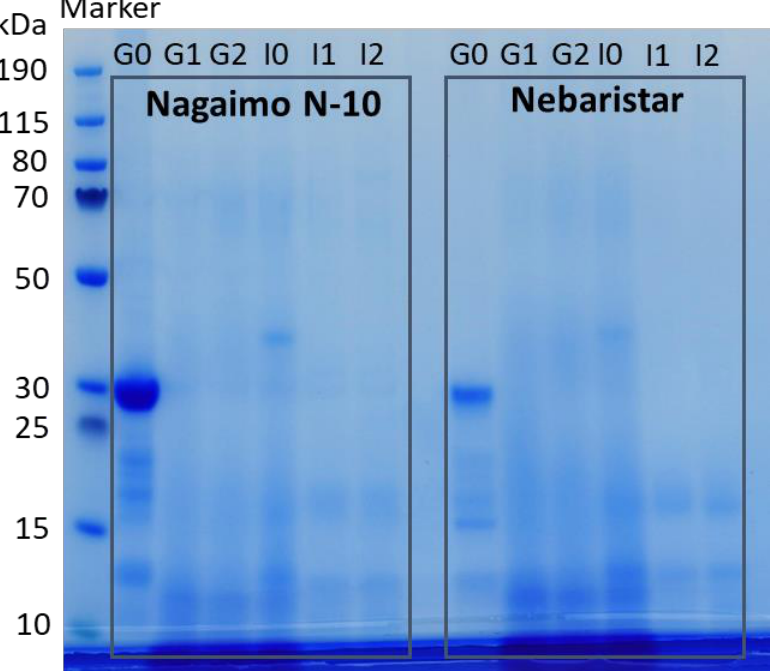
Figure 3. The electrophoretic patterns of the undigested yam protein and soluble protein subfractions at different digestion stages.